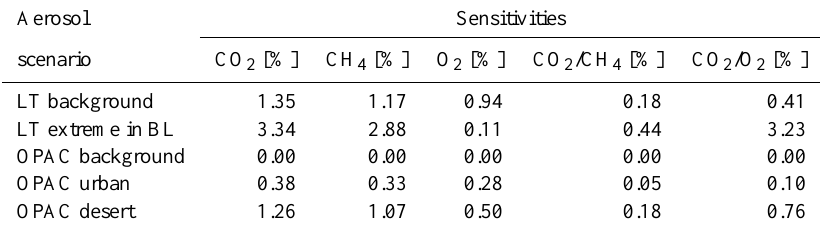
Table 3. Aerosol sensitivity of total column concentrations and their ratios for an aircraft altitude of 1.25km. Lowtran (LT, using